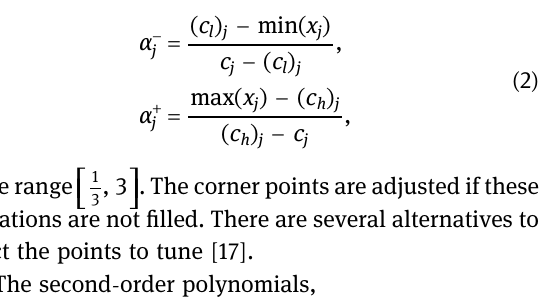
Figure 3: Triangular episodic representations de fi ned by the index ( ) I k jT and the derivative ( ) I k Δ jT